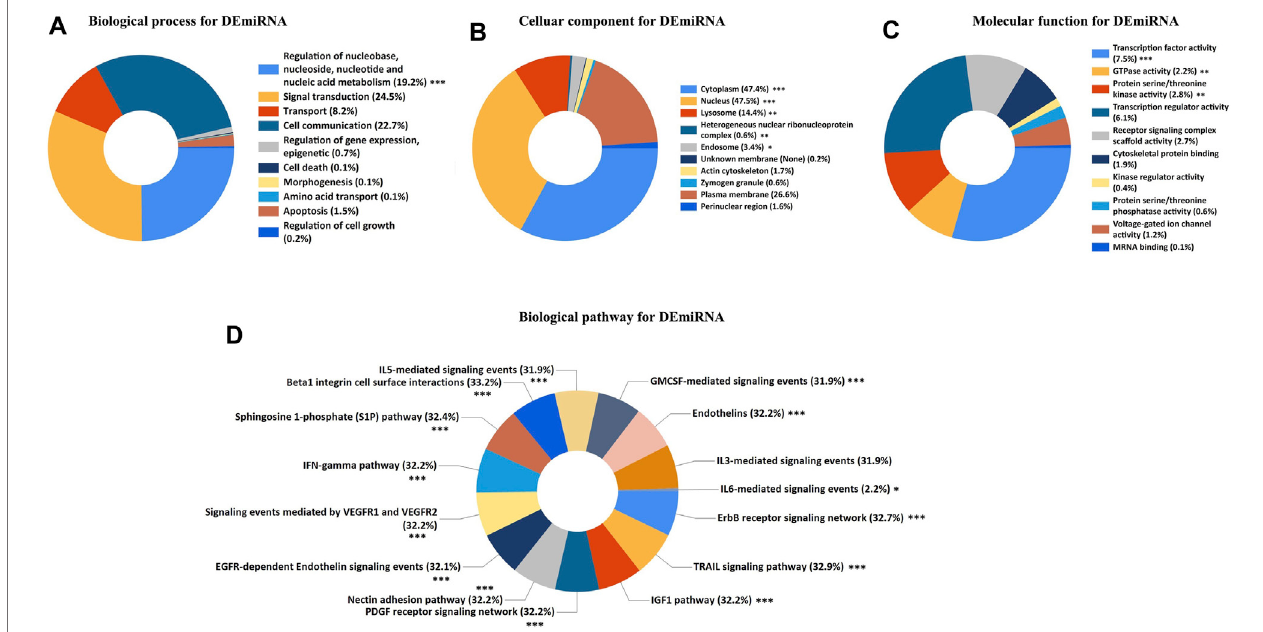
FIGURE 3 | GO and biological pathway analysis for DEmiRNAs. (A) Biological process for DEmiRNAs. (B) Cellular component for DEmiRNAs. (C) Molecular function for DEmiRNAs. (D) Biological pathway for DEmiRNAs. The asterisks represented the statistical p. value ( p p. value < 0.05; pp p. value < 0.01; ppp p. value < 0.001).